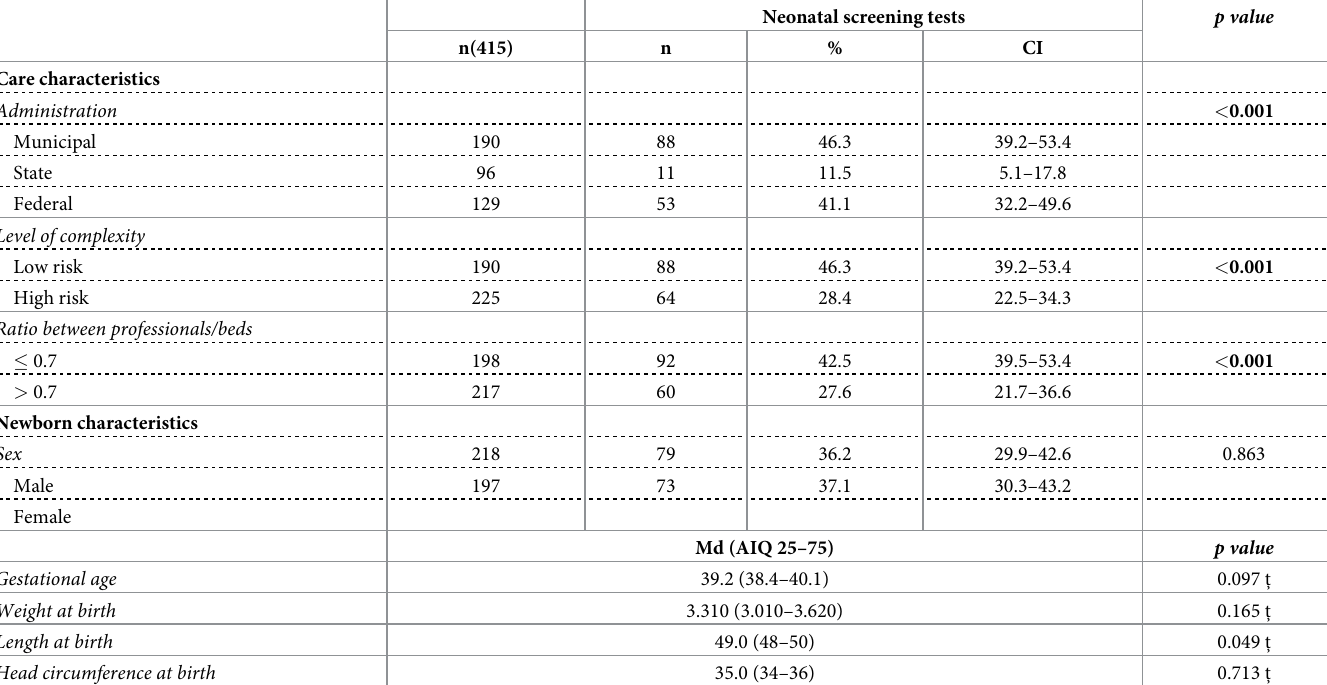
Table 3. Bivariate analysis of institutional and newborn characteristics with the of the five NS tests (n = 152). Natal/Brazil,